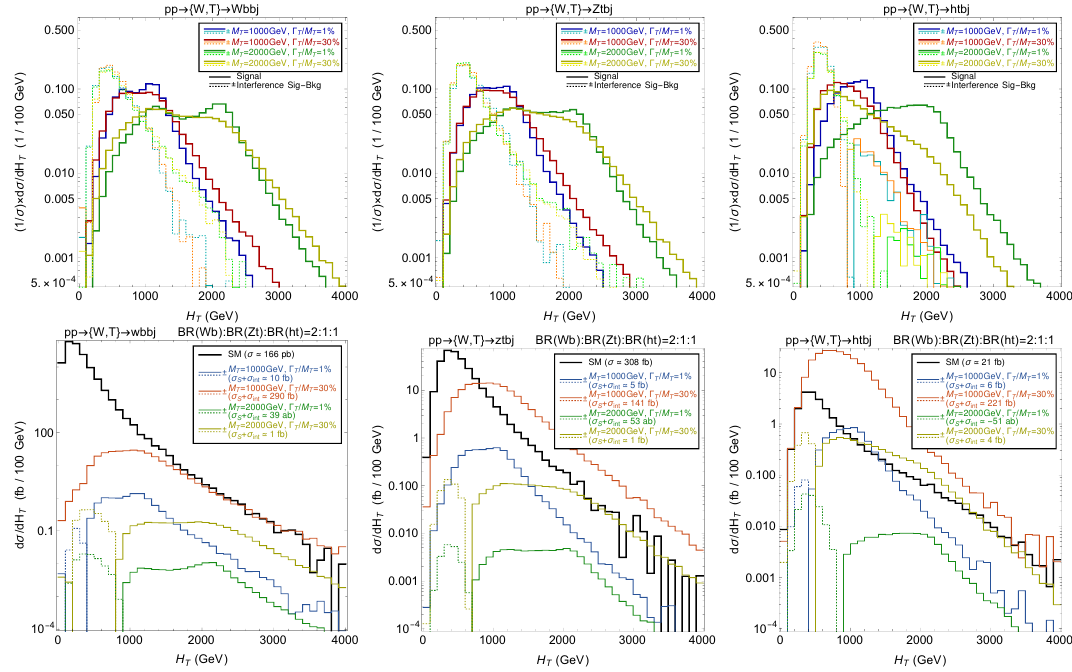
Figure 10 . H T distribution at the reconstructed level for the pp → Wbbj (left), Ztbj (centre) and htbj (right) processes. We consider two values of the T mass ( 1000 GeV and 2000 GeV ), and two values of the Γ ratio (1% and 30%). In the top row, we focus on the shapes of the T /M T signal contributions as well as on those associated with the interference of the signal with the SM background. In the bottom row, the sum of the signal and interference contributions is performed following eq. (3.15), the couplings are chosen according to the singlet case (see figure 9), and we compare the predictions with the SM expectation. Analogous results for T production through Zt exchanges are given in figure